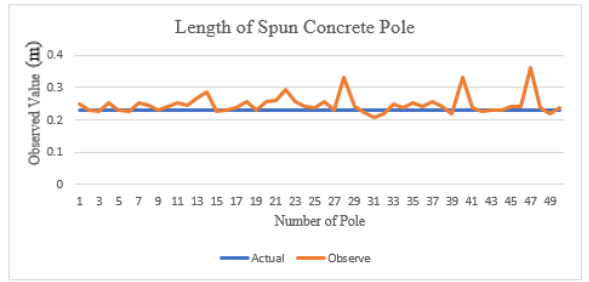
Figure 13 . The Length of Concrete Pole